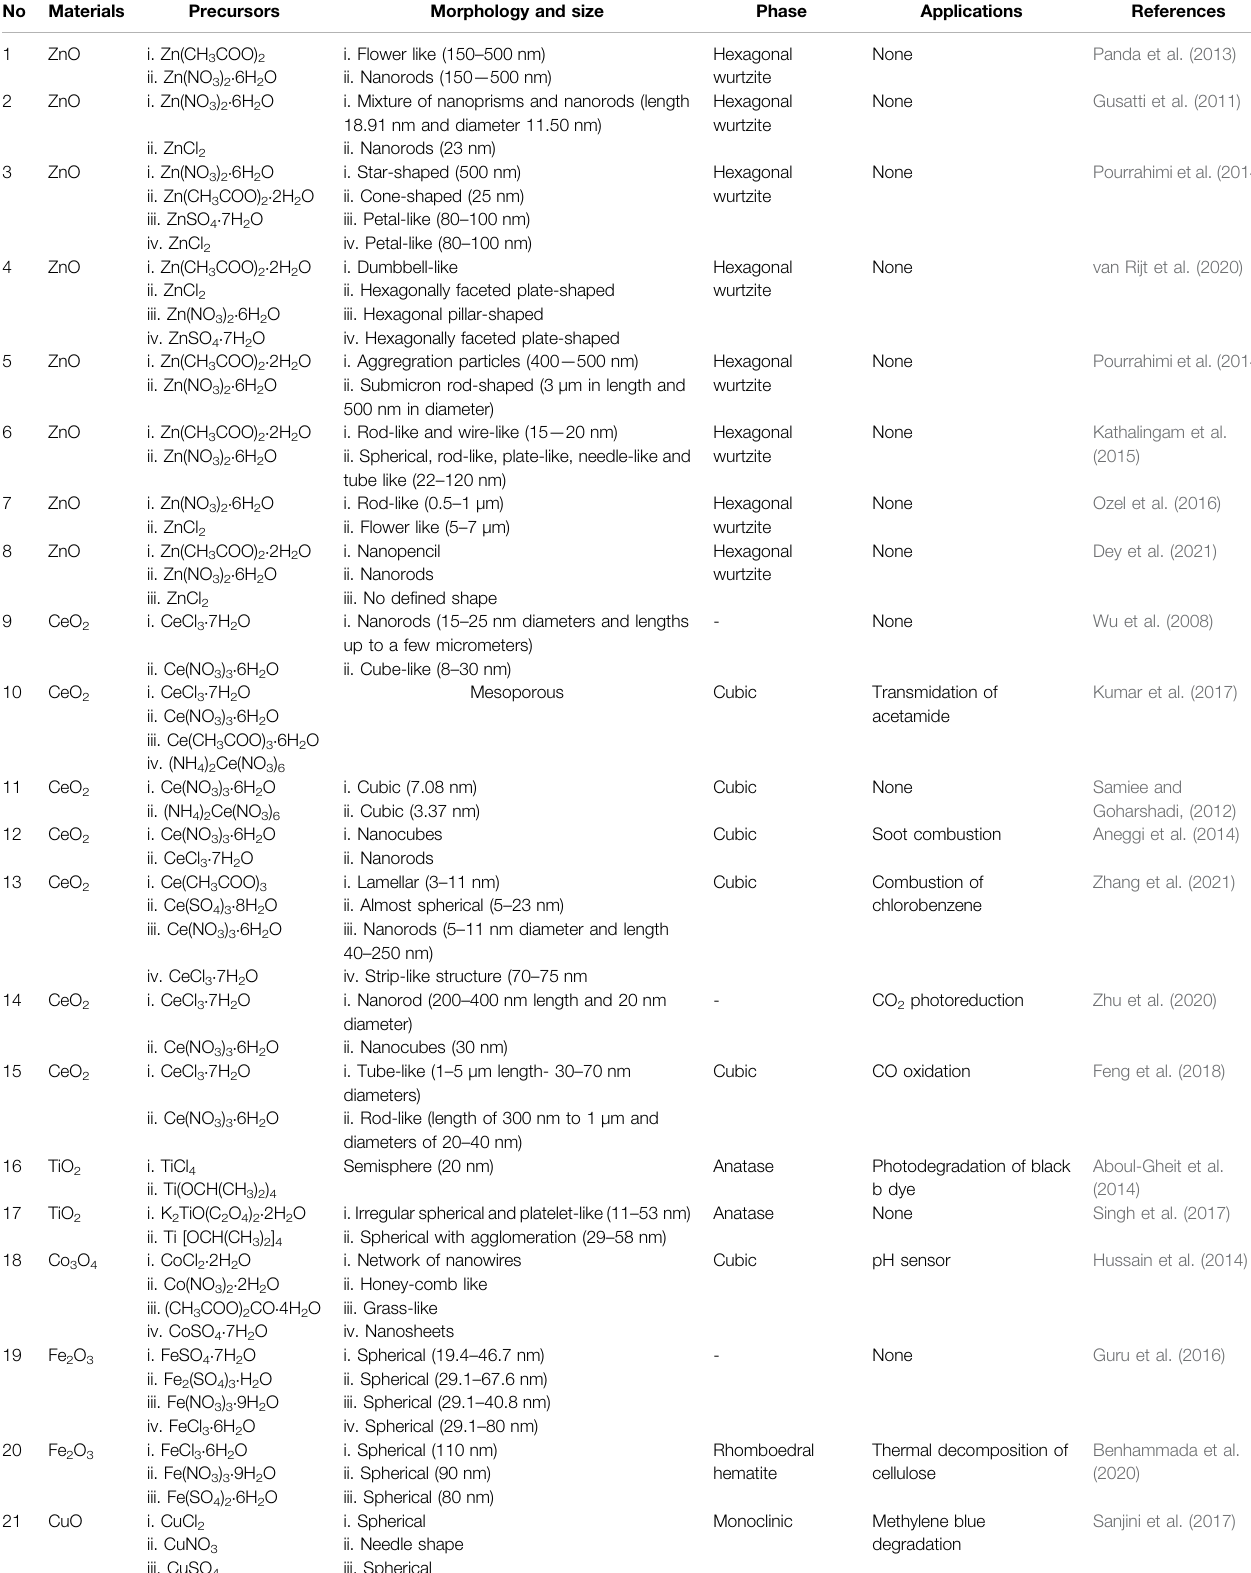
TABLE 1 | Various metal oxides synthesized using different